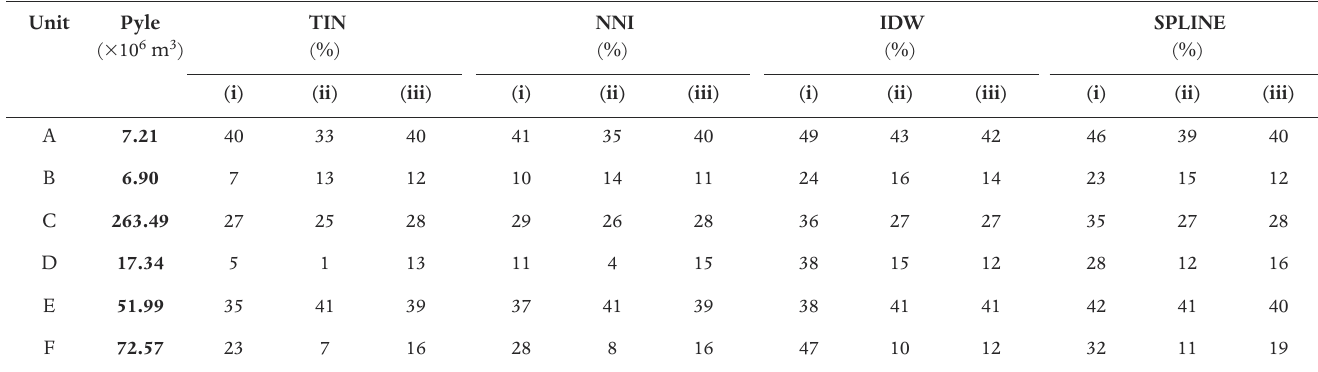
Table 3. Discrepancies between Pyle volume and SInt volume ( D ) calculated for the studied volcanic units (A-F). See text for